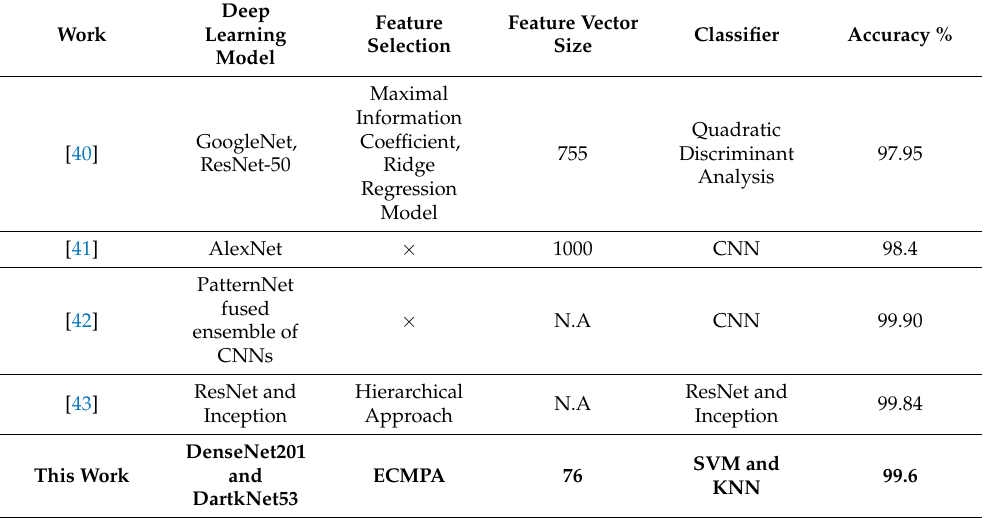
Figure 7. Convergence performance of ECMPA and GA. Figure 6: Convergence performance of ECMPA and GA Table 4. Performance Comparison of proposed method with some existing works. × : Not done, N.A: Information not